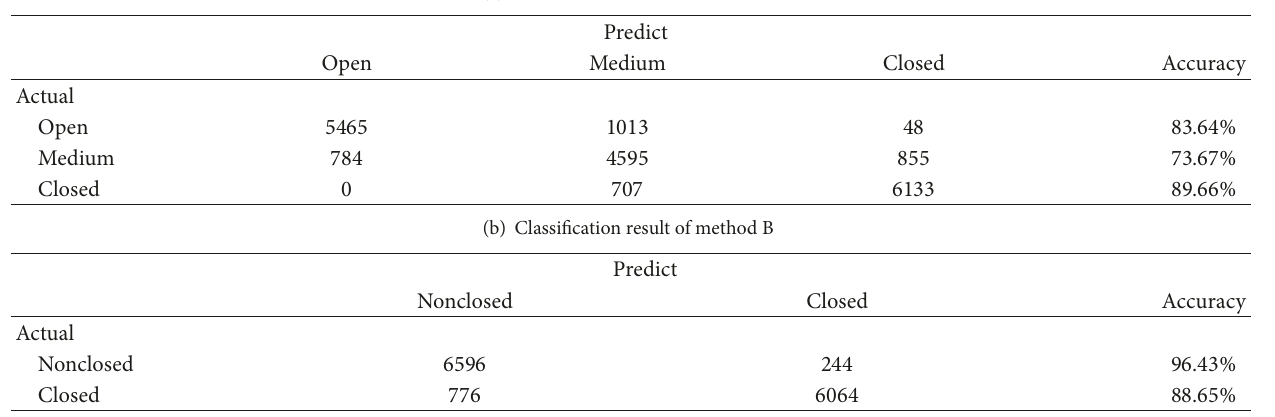
Table 2: Confusion matrices of CNN classification model.